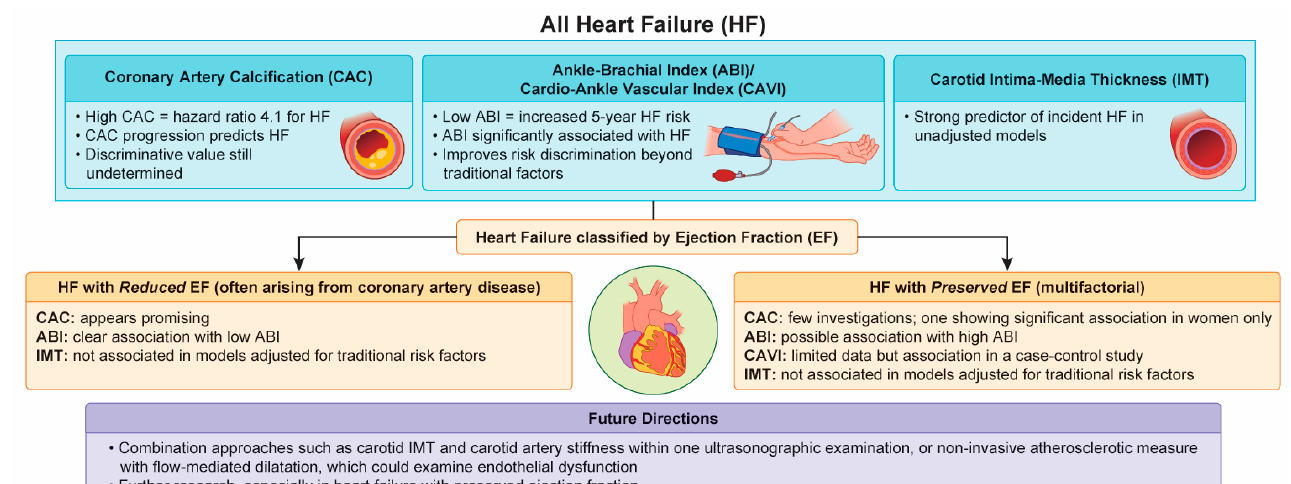
Figure 2. Clinical significance of non-invasive modalities used for assessment of atherosclerosis when evaluating the potential risk of heart failure.